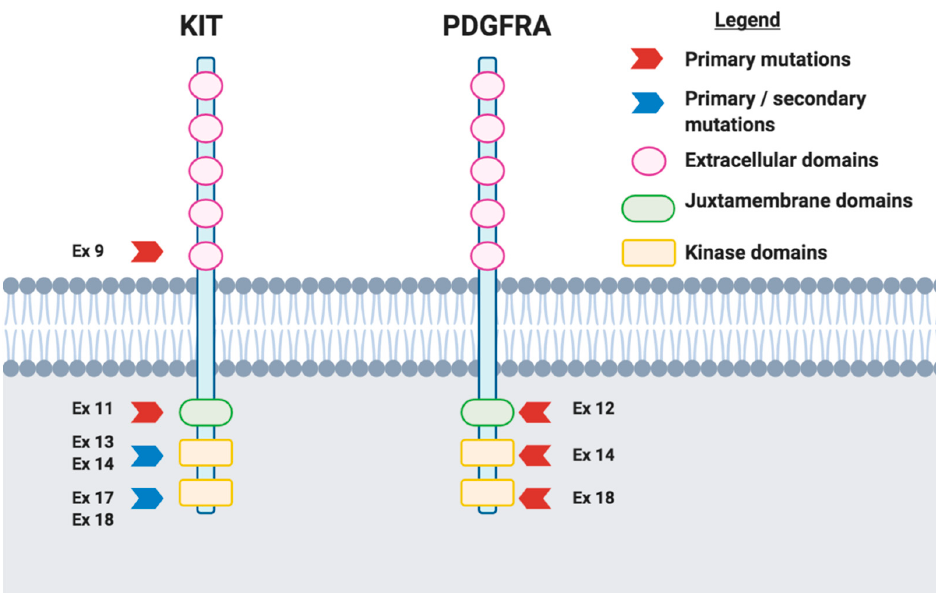
Figure 1. Schematic figure representing primary and secondary KIT and platelet-derived growth factor receptor (PDGFRA) mutations observed in gastrointestinal stromal tumors (GIST). Briefly, exon 11 is the most frequently mutated exon in GIST patients, with these mutations detected in about 60% of cases; exon 9 represents the second most commonly mutated exon (10–12% of cases). Regarding PDGFRA, mutations occurring in a specific hotspot in exon 18 are known as D842V mutations and confer resistance to imatinib.